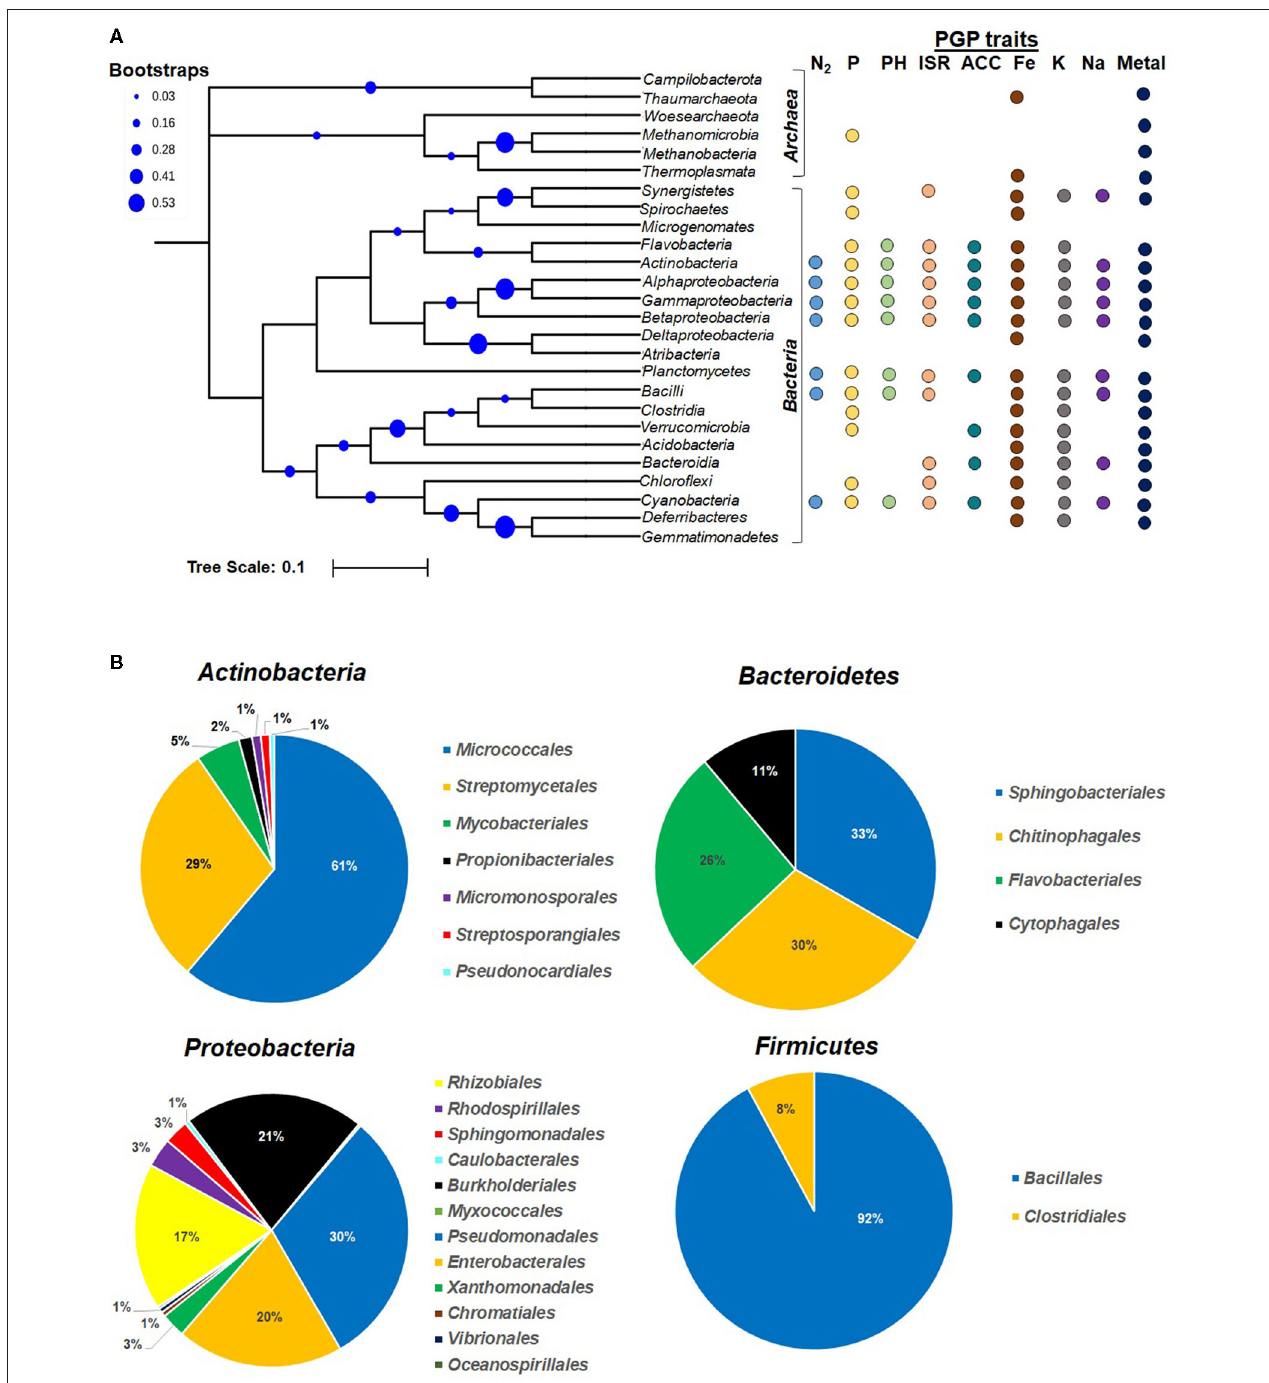
FIGURE 1 | Phylogenetic diversity and percent abundance of prokaryotes involved in various plant growth promotion activities. (A) Phyla Proteobacteria , Firmicutes , and Euryarchaeota are further classified at class level. The root indicates the LUCA (last universal common ancestor). (B) Pie chart showing relative distribution (% abundance) of major PGP taxa reported in RDP II and NCBI taxonomy databases. The contributions of each PGP taxa in (A) are denoted with colored dots corresponding to each specific PGP traits. The scale bar 0.1 indicates substitution (10%) at nucleotide level of 16S rRNA gene, and blue circles indicate the bootstrap values (in %). N 2 , dinitrogen fixation; P, phosphate solubilization; PH, phyto-hormone production; ISR, induced systemic resistance; ACC, ACC deaminase; Fe, iron (siderophore) uptake; K, potasium uptake; Na, sodium uptake; Metal, heavy metal transformation and bioremediation.